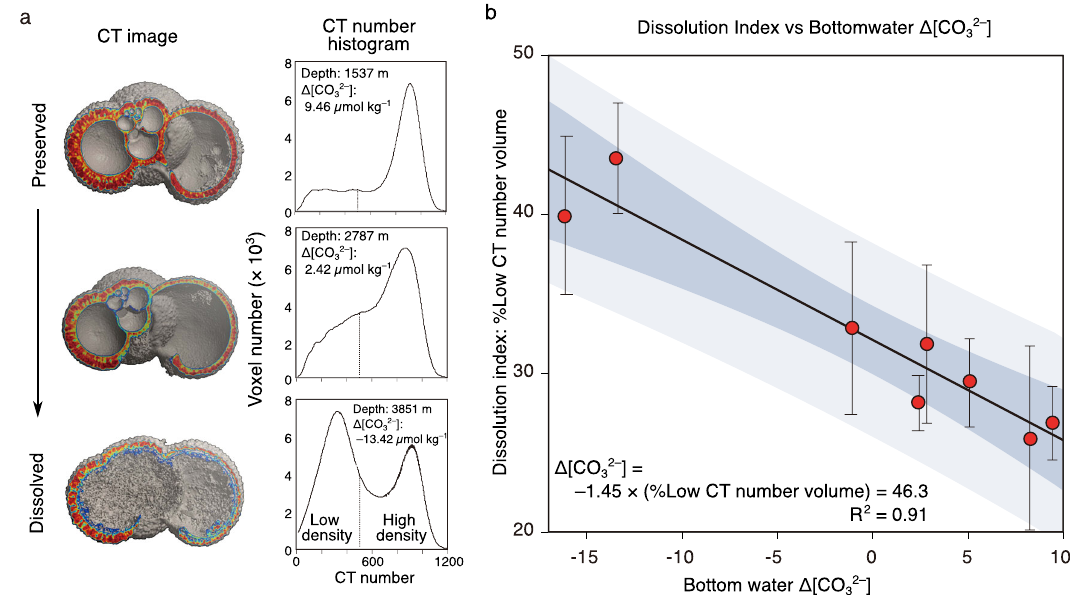
Fig. 2 | Test dissolution process and CT-based proxy calibration with deep- water Δ [CO 3 2 − ] using core-top samples. a Variations in cross-section iso-surface images and Computer tomography (CT) number histograms of G. bulloides tests withdissolution.Typicalconditionoftestsisselectedfromeachsampleandshown. Tests were obtained from the three core-top samples from depths of 1537, 2787, and 3851m, and deep-water Δ [CO 3 2 − ] of 9.46, 2.42, and – 13.42 µ molkg – 1 ,